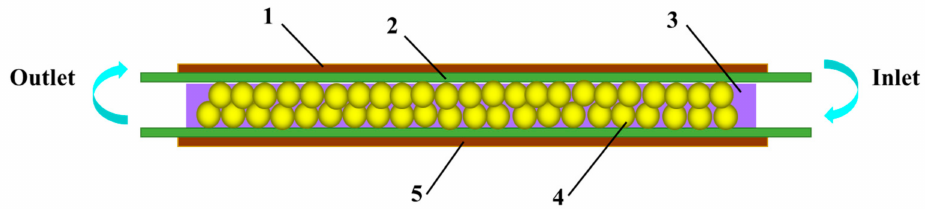
Figure 12. Schematic diagram of the DBD regeneration reactor: 1, high voltage electrode; 2, quartz glass; 3, plasma area; 4, resin; and 5, ground electrode.